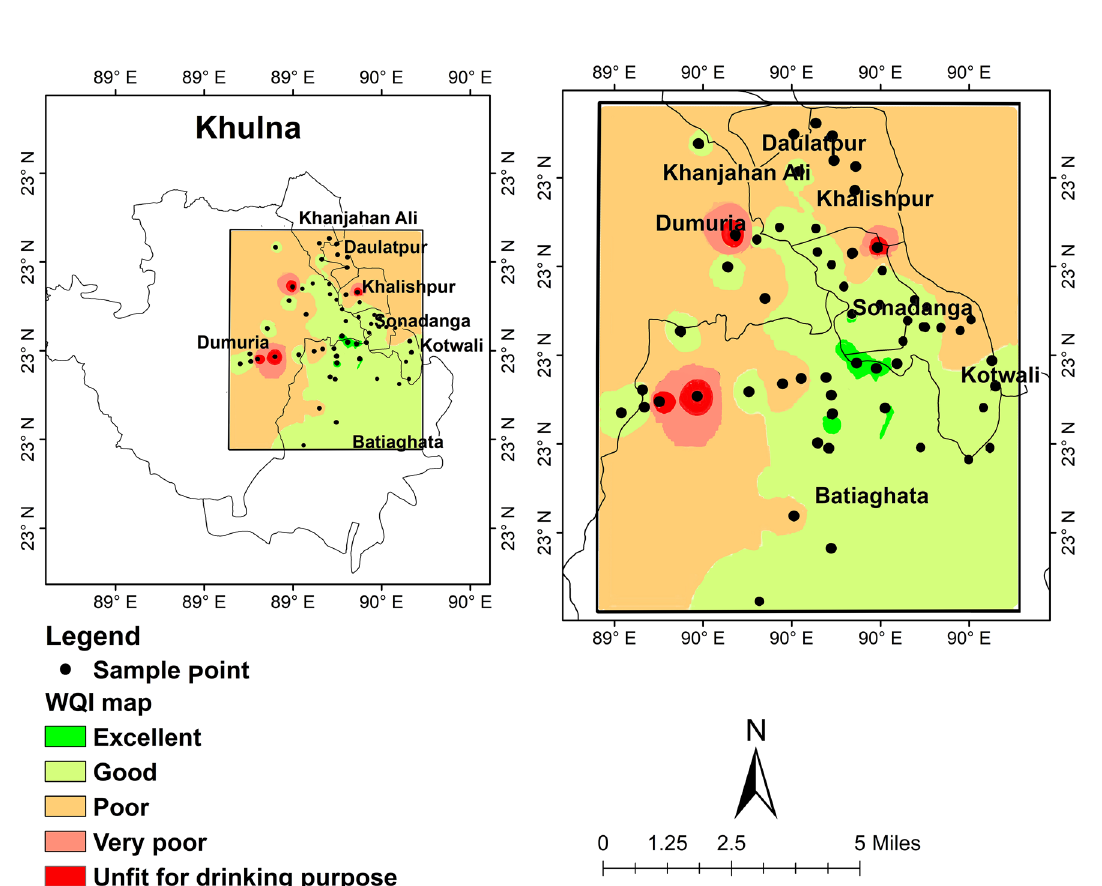
Fig. 10 Water quality index map for selected sampling